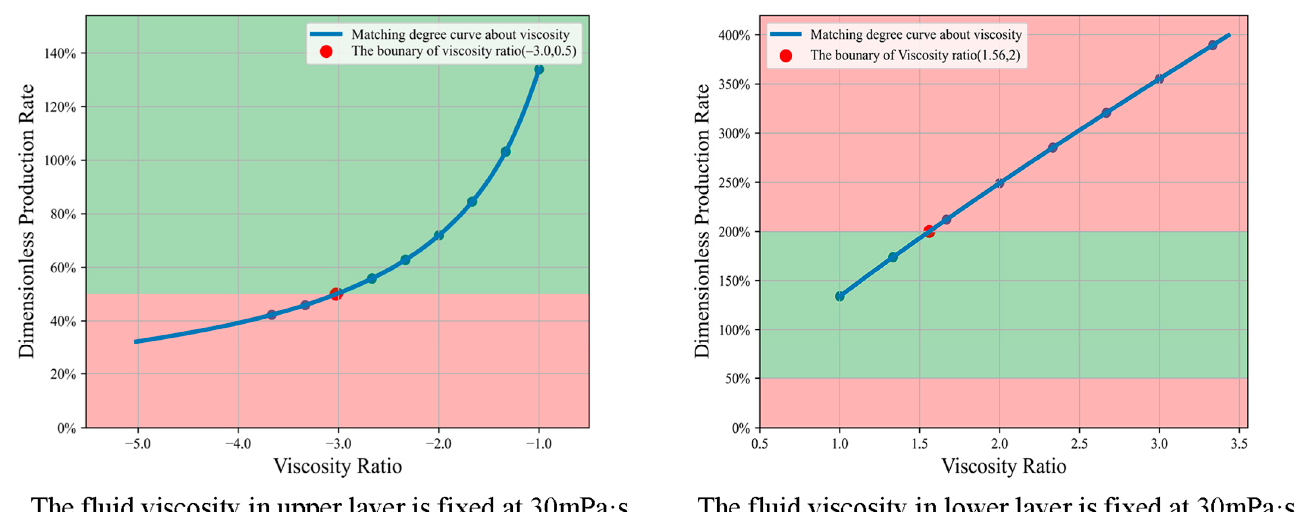
Figure 18. Matching degree curve about viscosity ratio.